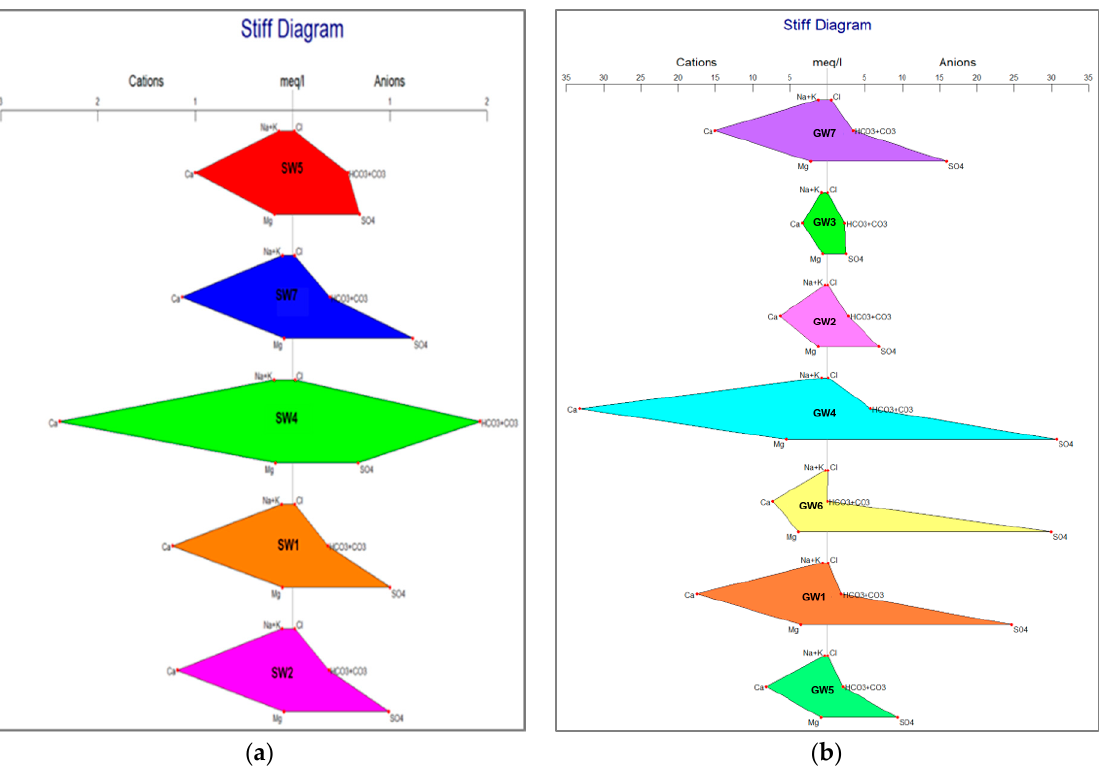
Figure 13. Stiff diagram for the chemical composition of surface and groundwater in water sam- ples.